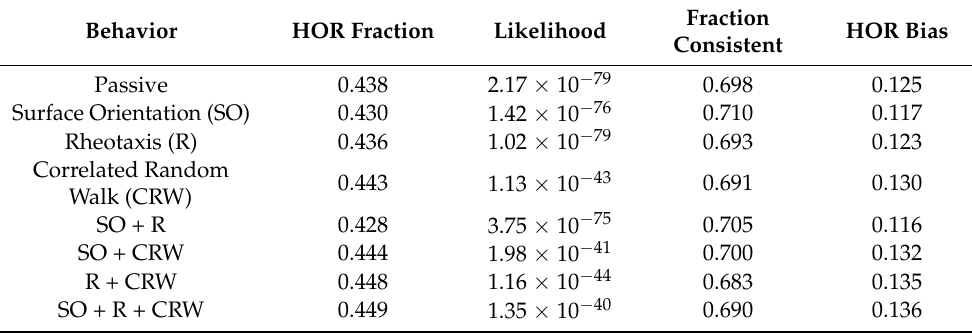
Table 1. Route selection and behavior evaluation metrics across all tags for each behavior formulation. HOR Fraction is the fraction of particles that have head of Old River route selection; Likelihood reports the metric described by Equation (11); Fraction Consistent reports the fraction of particles with route selection consistent with their associated tag; HOR Bias reports the difference between the fraction of particles with HOR route selection for tags with San Joaquin River route selection minus the fraction of particles with San Joaquin Route selection for tags with HOR route selection. Fraction HOR Bias Behavior HOR Fraction Likelihood Consistent Passive 0.438 2.17 × 10 − 79 0.125 Surface Orientation (SO) 0.430 Correlated